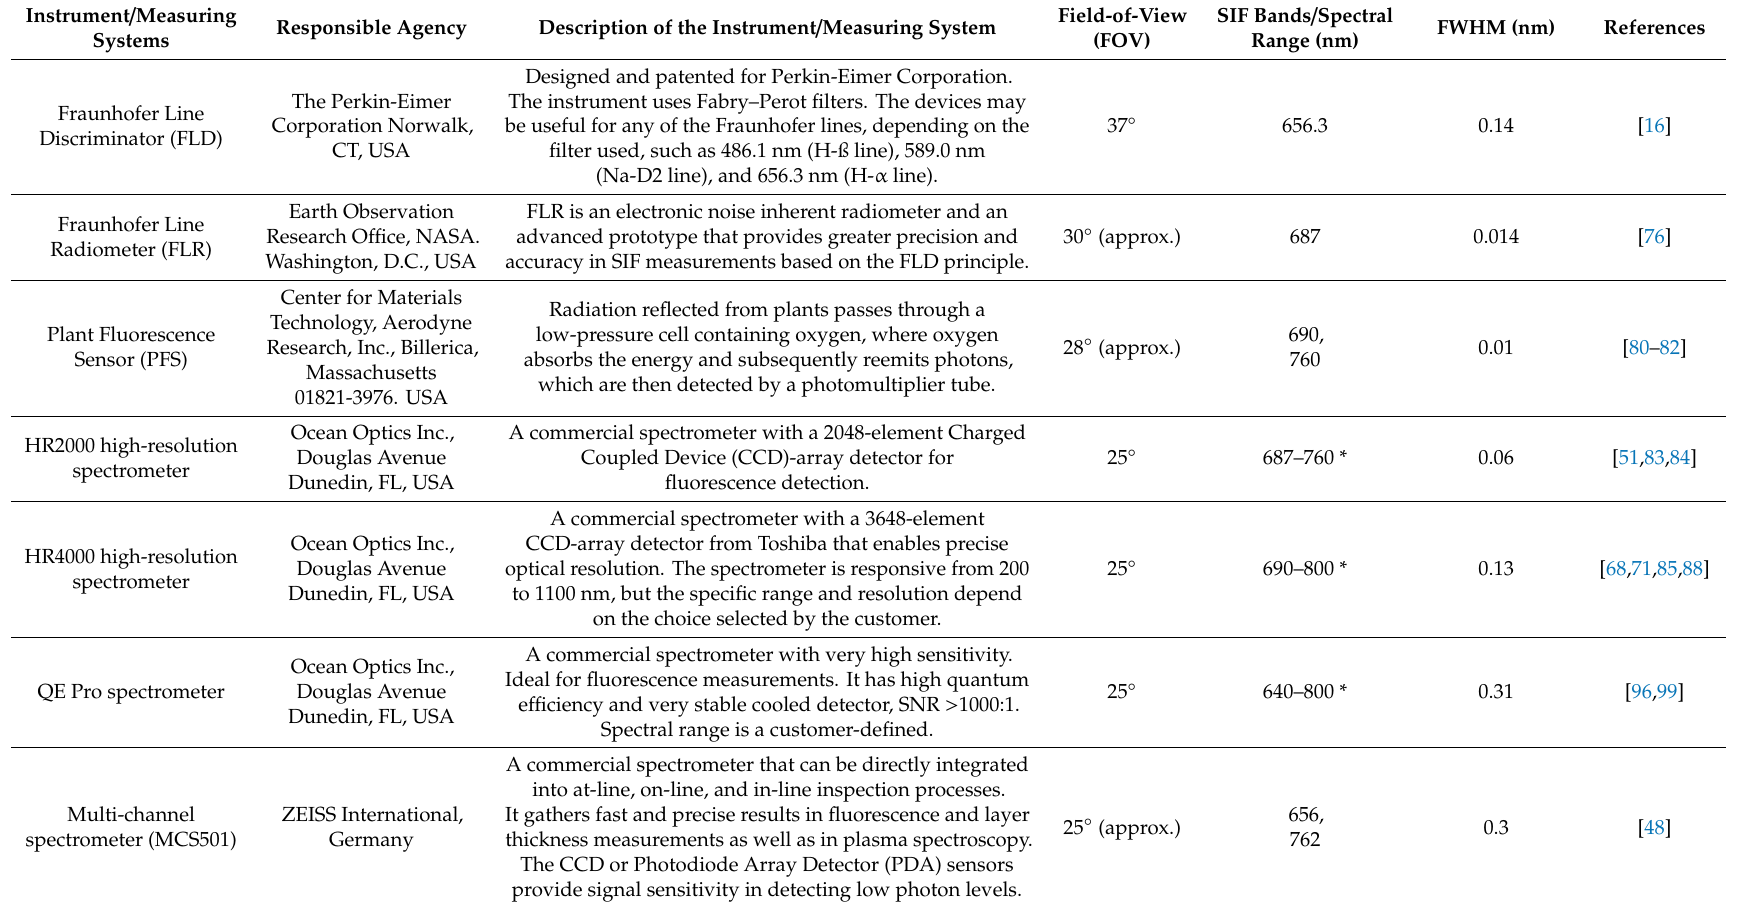
Table 2. Characterization of the main instruments and measuring systems used for SIF